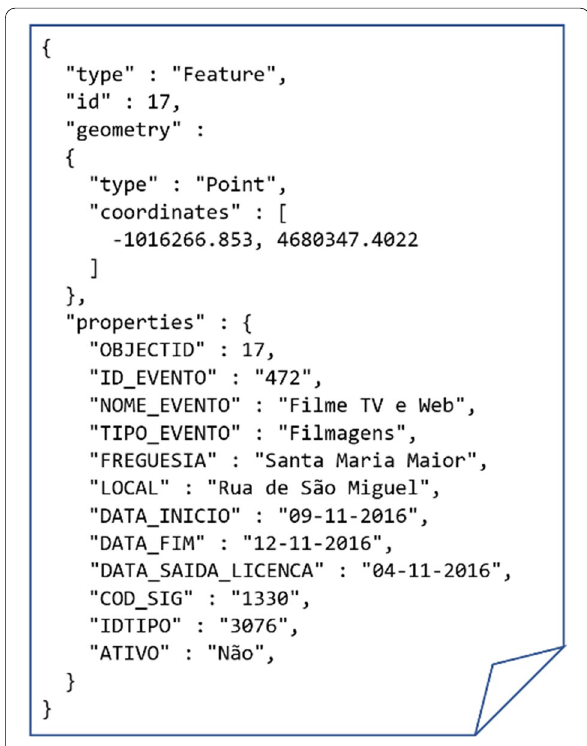
Fig. 3 Illustrative interdiction with the road trajectory and time ranges of applicability specified in geoJSON